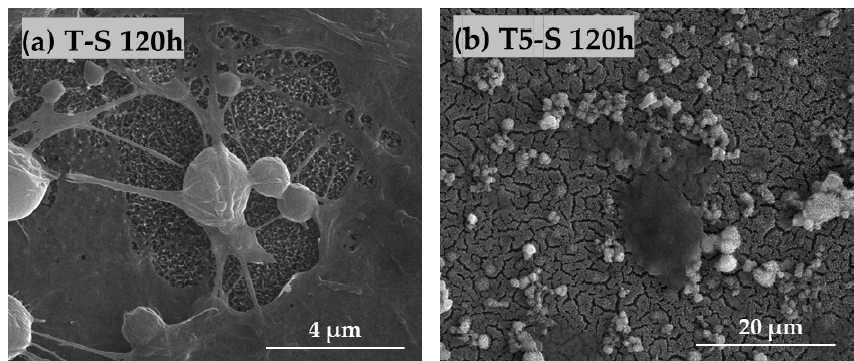
Figure 14. Comparative SEM images showing human ADSCs cultured on the surface of T-S ( a ) and T5-S ( b ) specimens for 120 h. The figures confirm evident differences in cell morphology for both samples: adherent cells with filopodia attached to the surface of T-S ( a ) and rounded cells without attachments on T5-S ( b ).